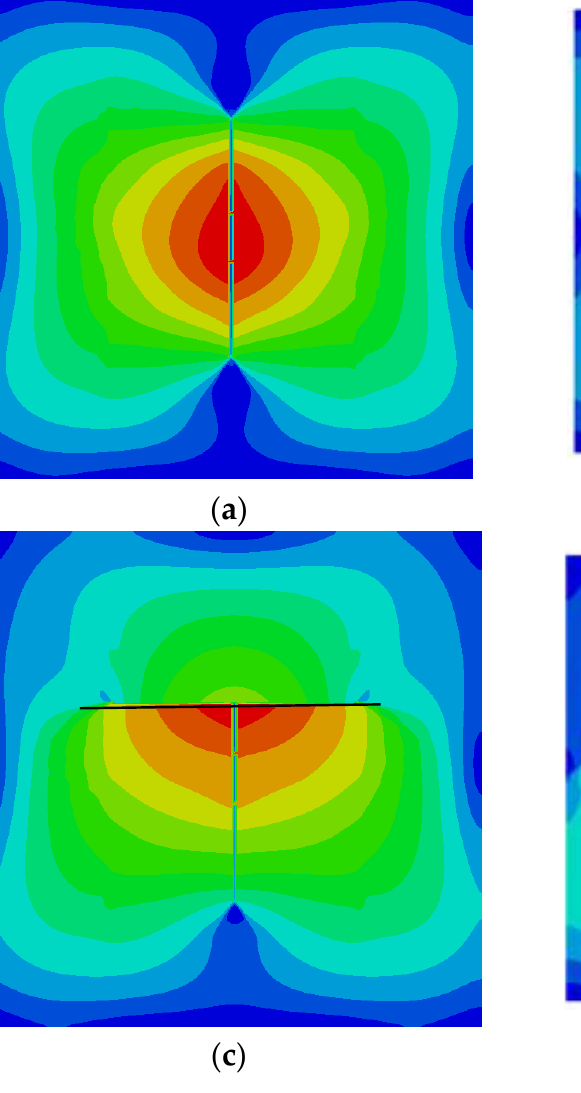
of 35 GPa and t = 55 s; ( b ) elastic modulus of 35Gpa and t = 100s; ( c ) elastic modulus of 45 Gpa and